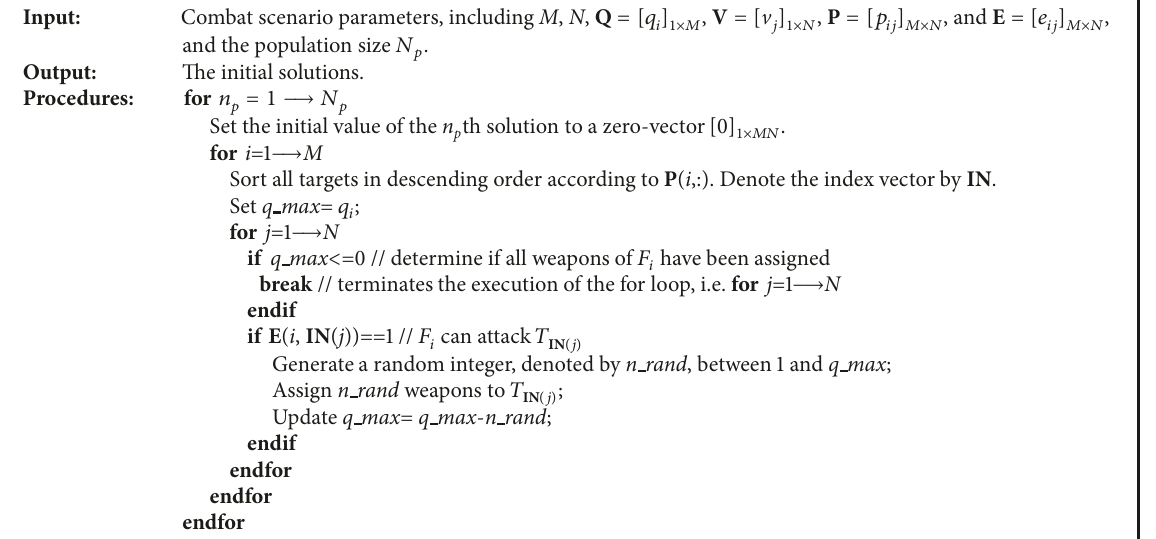
Algorithm 1: Pseudo-code of the initialization